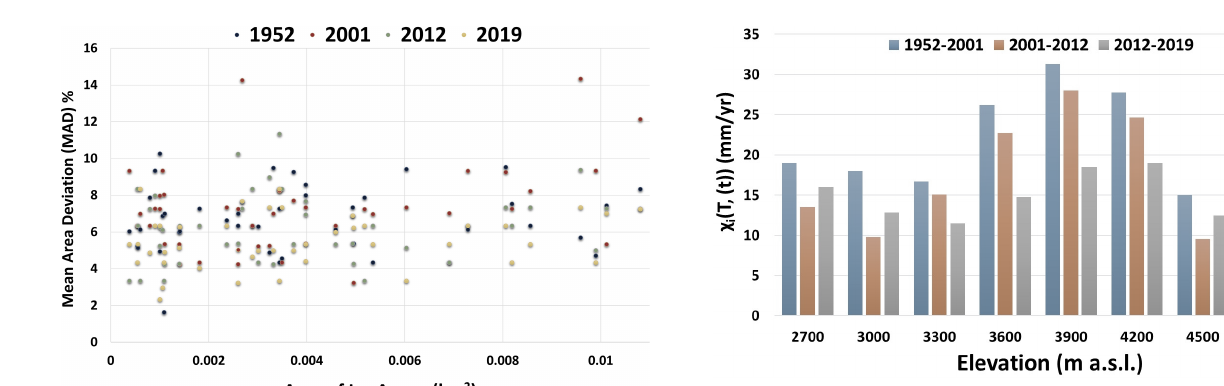
Figure 12. Variation of the average accumulation rates on steep slopes at different elevations for each period of observation.